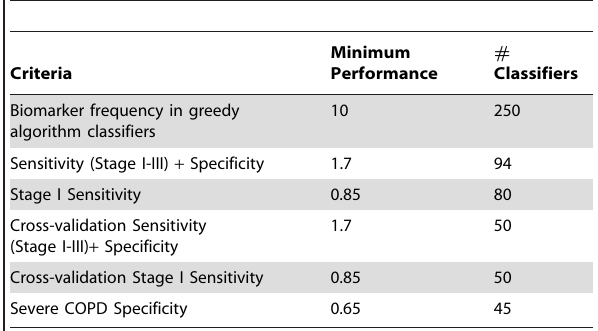
Table 6. Performance of Bayesian Classifier to distinguish NSCLC cases from